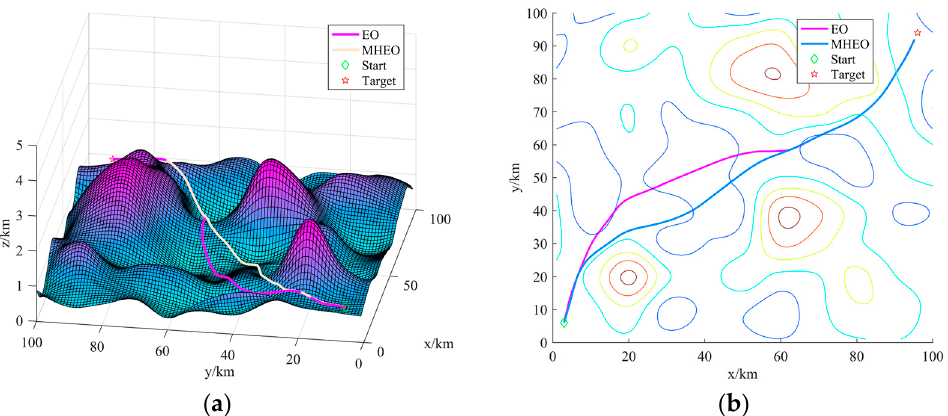
Figure 4. The best path of each algorithm: ( a ) path in three-dimensional space; ( b ) path in three-dimensional space.